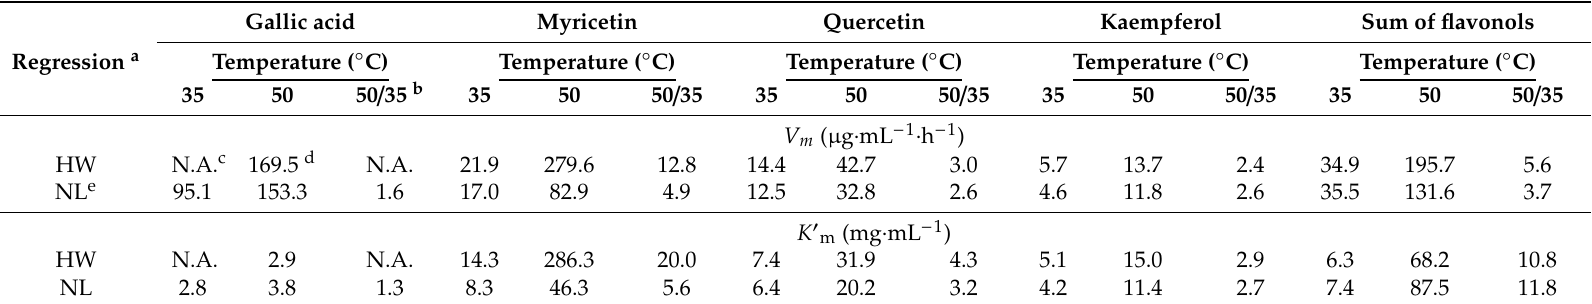
Table 2. Kinetic parameters of the enzyme